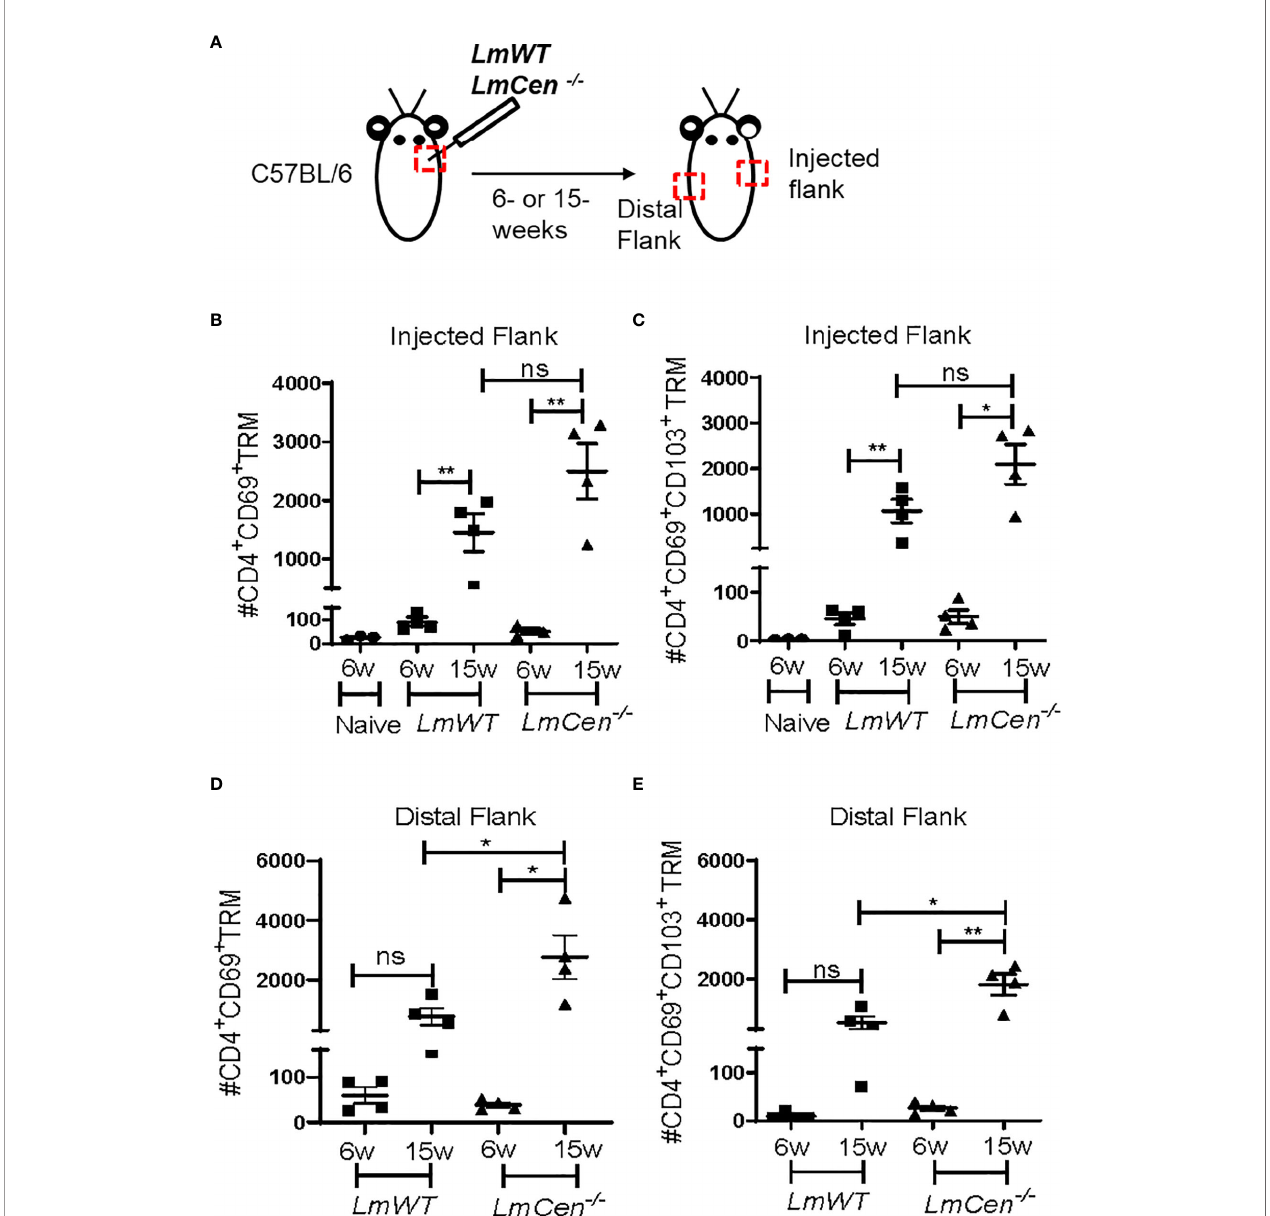
FIGURE 1 | Immunization with LmCen -/- generates CD4 + TRM cells in the skin. Mice were injected, intradermally, with either LmCen -/- or L. major wild-type ( LmWT) parasites in the right fl ank, and TRM cell population was assessed at 6 and 15 weeks post-injection by fl ow cytometry from both right (injected fl ank) and left fl ank (distal fl ank) marked by the red box. Baseline TRM population was measured in fl ank skin of non-immunized mice. (A) Schematic plan of injection site and experimental time points. (B, C) TRM cell population in the injected fl ank. (B) CD4 + CD69 + TRM cells and (C) CD4 + CD69 + CD103 + . (D, E) TRM cell population in the distal fl ank. (D) CD4 + CD69 + TRM cells and (E) CD4 + CD69 + CD103 + collected from LmWT and LmCen -/ – injected mice at 6 and 15 weeks post-injection. The Y axis represents the number of TRM cells per 10e6 total cells acquired. Results are representative of one of two independent experiments with n = 3 – 4 mice per group. Bars represent the means with SEM in each group. Statistical analysis was performed by unpaired two-tailed t-test (** p < 0.009, * p < 0.05, ns, not signi fi